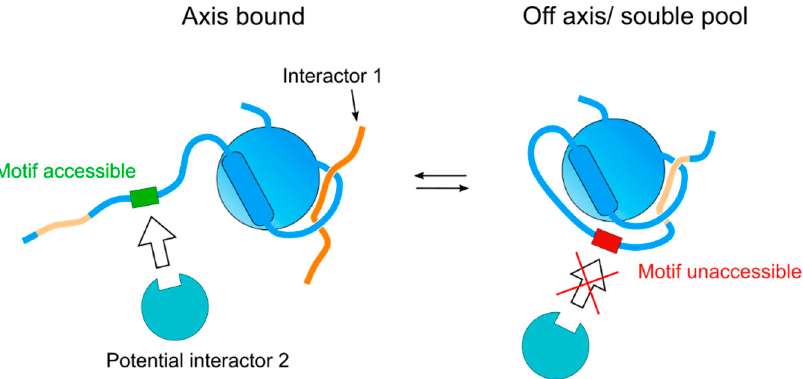
Figure 4. Graphical representation of a possible self-regulatory pathway utilized by meiotic HOR- MADs. Interactor 1 represents a canonical safety belt-CM interaction, interactor 2 represents a binding partner mediated through another interface. Although the additional hypothetical motif is represented here on the flexible C-terminus, it represents any motif within the protein that could be affected upon a conformation change.